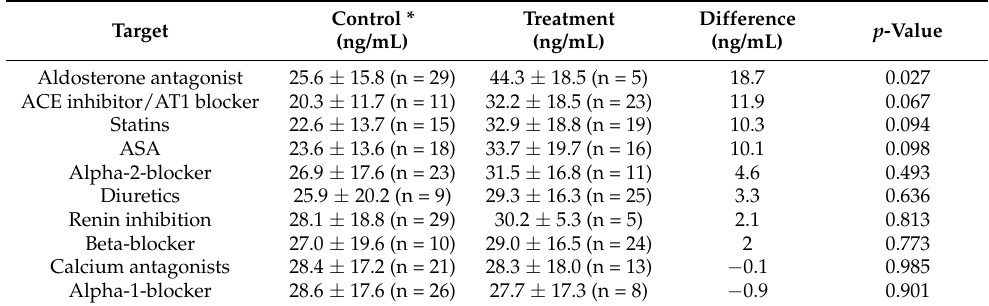
Table 2. Effect of treatment on plasma concentrations of LOX in hypertensive patients (cohort 1).